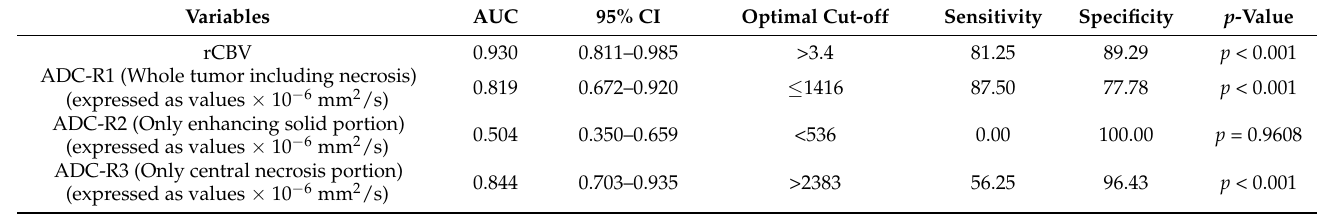
Table 2. Details of ROC curve analysis with AUC of all parameters.